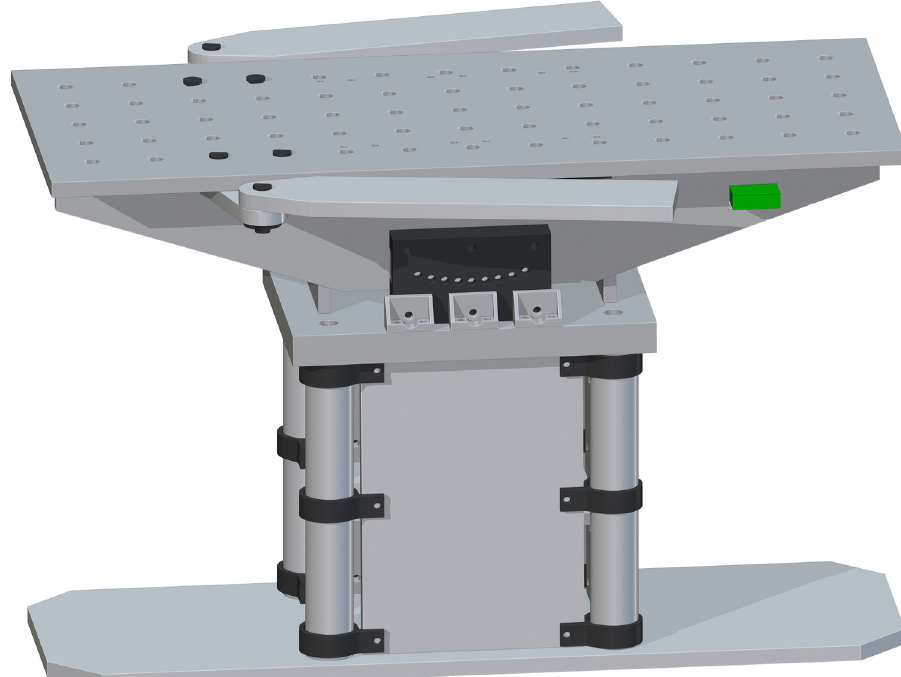
Fig 16. Addition of Distancing Brace through the Table Top Support.